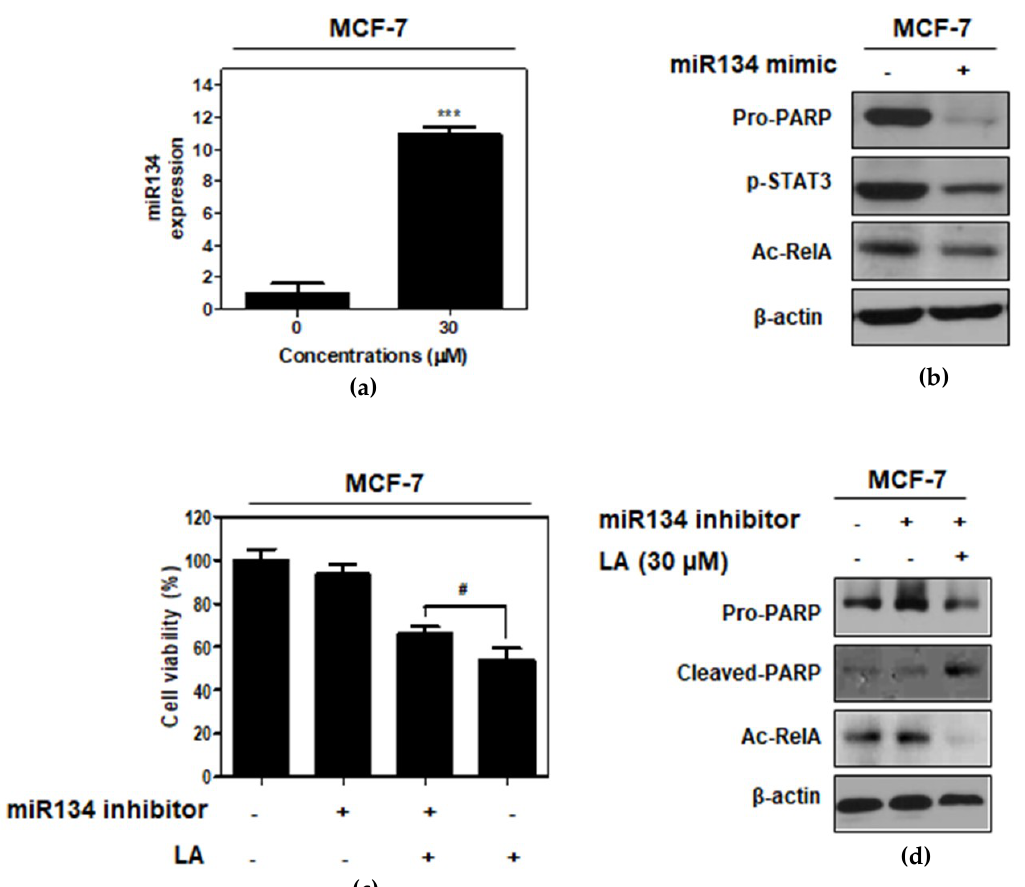
Figure 6. The pivotal role of miR134 in the LA-induced apoptotic effect in MCF-7 cells. ( a ) Effect of LA on the miR134 level in MCF-7 cells by qRT-PCR. *** p < 0.001 vs untreated control. ( b ) Effect of miR134 mimic on PARP, p-STAT3, and Ac-RelA in the MCF-7 cells. ( c ) Effect of the miR134-inhibitor on the viability of the MCF-7 cells with or without LA. # p < 0.05 vs LA alone treated control. ( d ) Effect of the miR134-inhibitor on PARP and Ac-RelA in the MCF-7 cells. Data represent means ± SD.